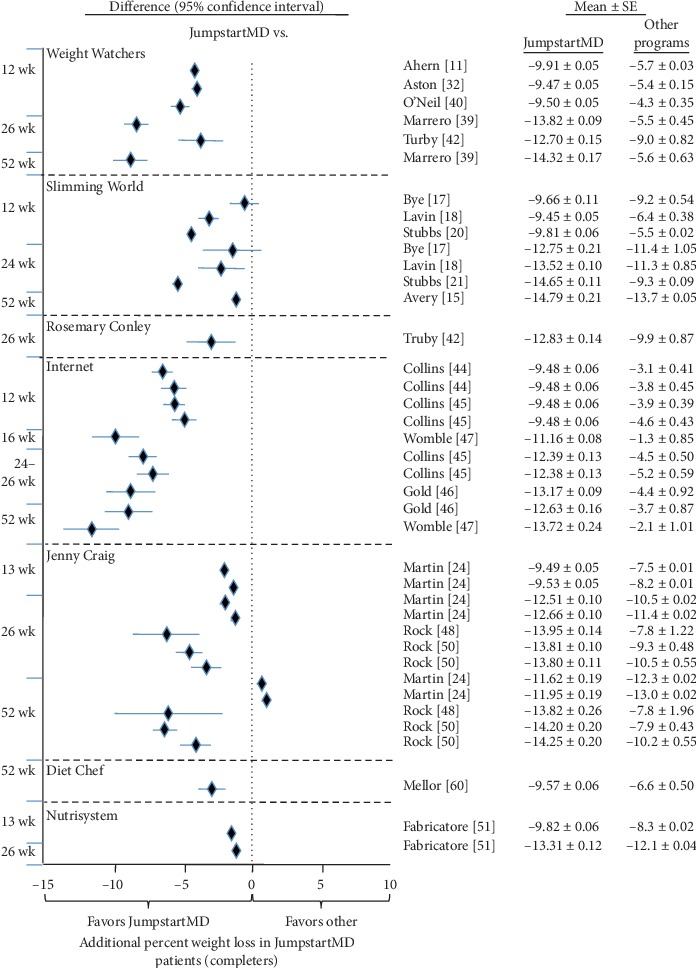
Mean weight loss difference between JumpstartMD and other commercial programs in completers as measured by percent weight loss. Negative differences designate greater JumpstartMD %weight loss. See legend to Figure 5 for further explanation.